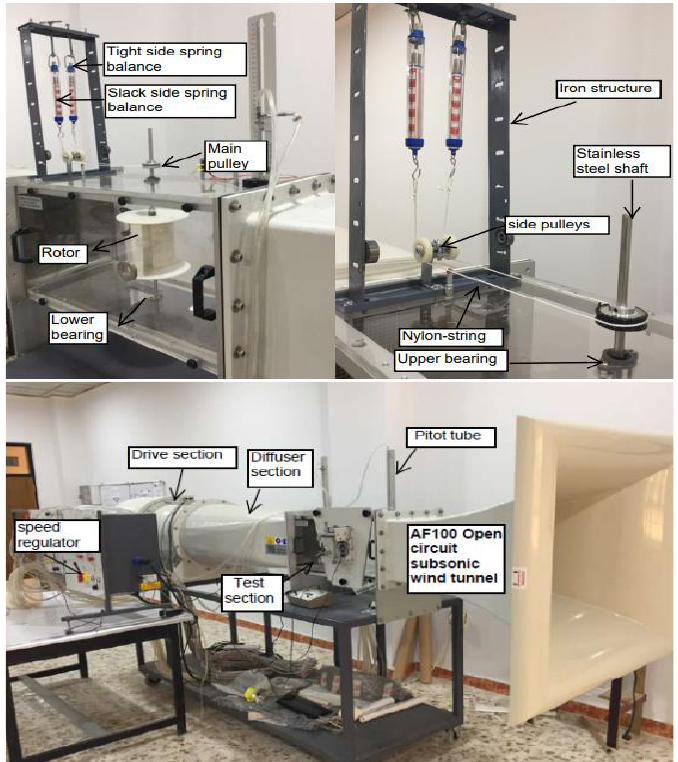
Figure 7. Testing of the Savonius turbine model at the subsonic open-type wind tunnel aerodynamic lab, METPD, Al-Furat Al-Awsat Technical University (ATU).